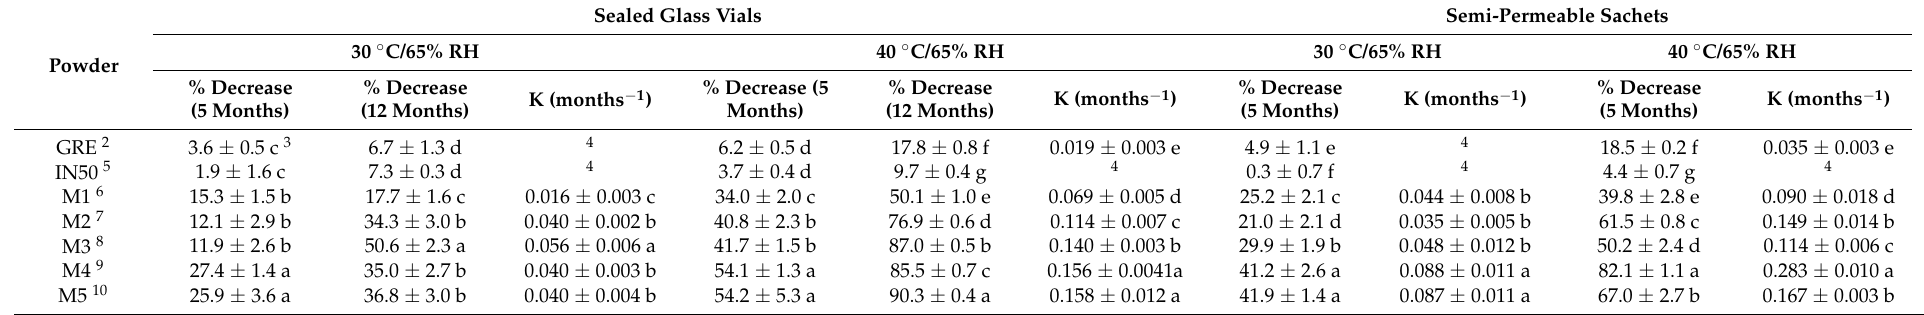
Table 2. Aspalathin degradation (%) and degradation rate constants (K) of the first order model 1 fitted to the experimental data representing aspalathin degradation in green rooibos extract powder and powder mixtures during storage at 30 ◦ C/65% RH and 40 ◦ C/65% RH for 12 months in glass vials and 5 months in semi-permeable